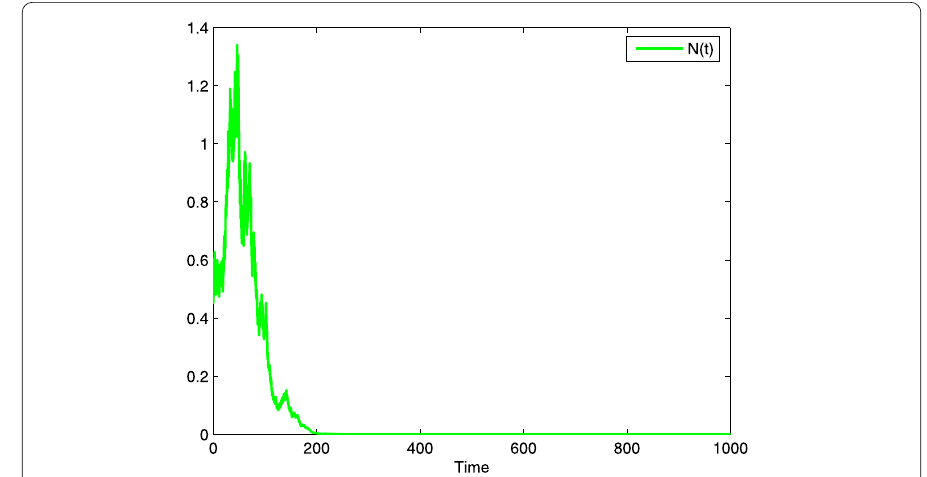
Figure 5 Hybrid system (16) with parameter values given in Fig. 4 except (cid:5) 2 (2) = 0.8. This figure suggests that the species represented by system (16)